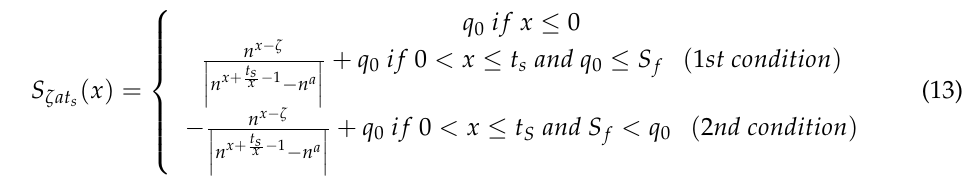
Figure 2. ( a ) presents the trajectory 𝑆 different shape of the trajectory